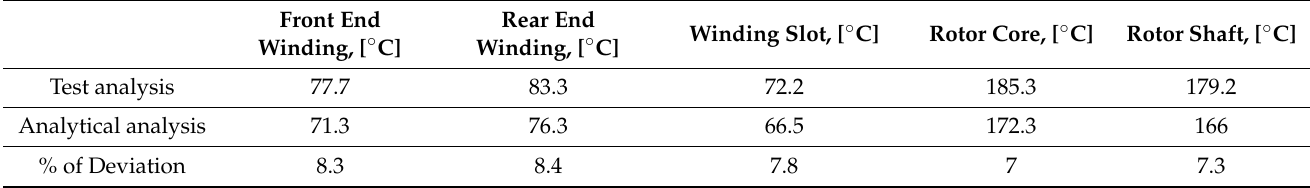
Table 1. Temperature distribution by thermal analysis